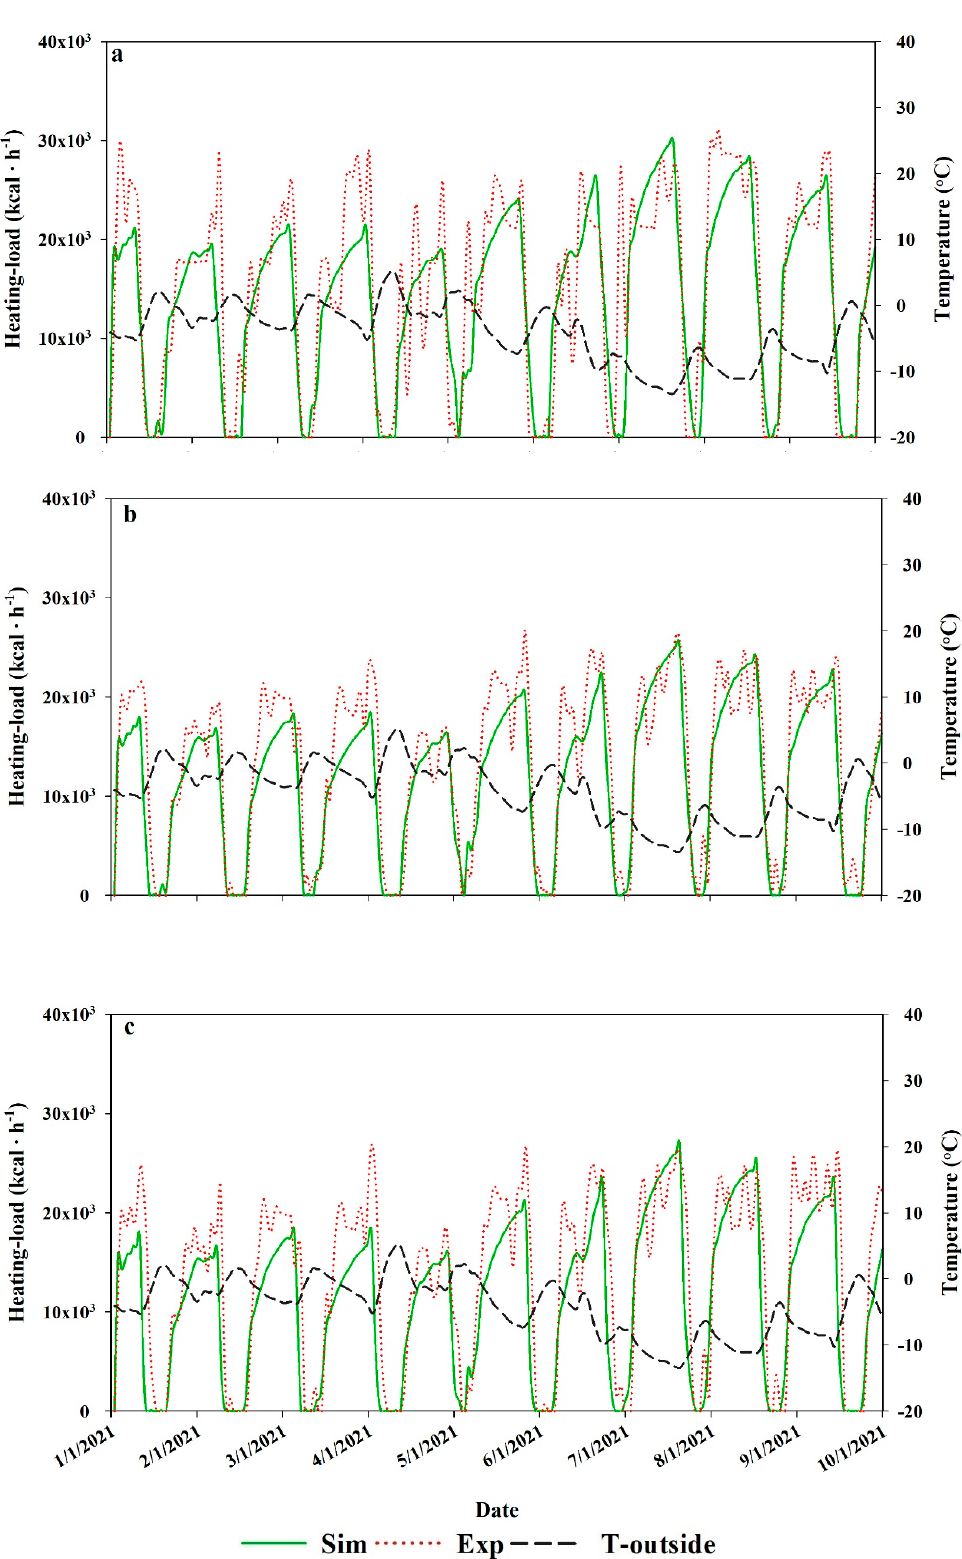
Figure 9. Experimental vs. simulated heating loads of greenhouse ( a ) compartment 1, ( b ) compartment 2, and ( c ) compartment 3.